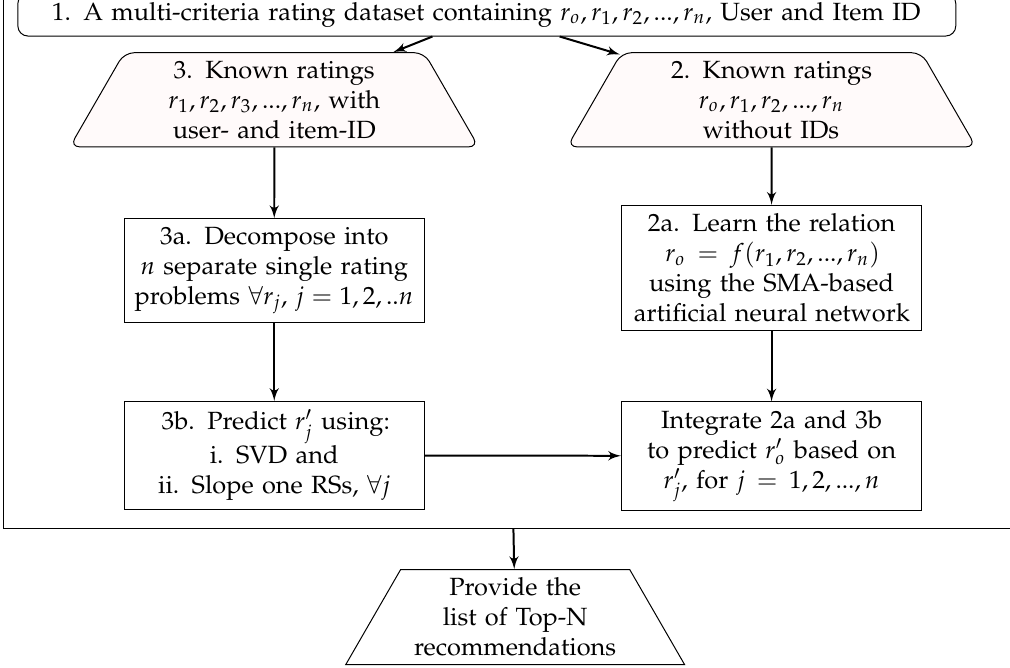
Figure 1. The framework of the proposed multi-criteria recommender systems